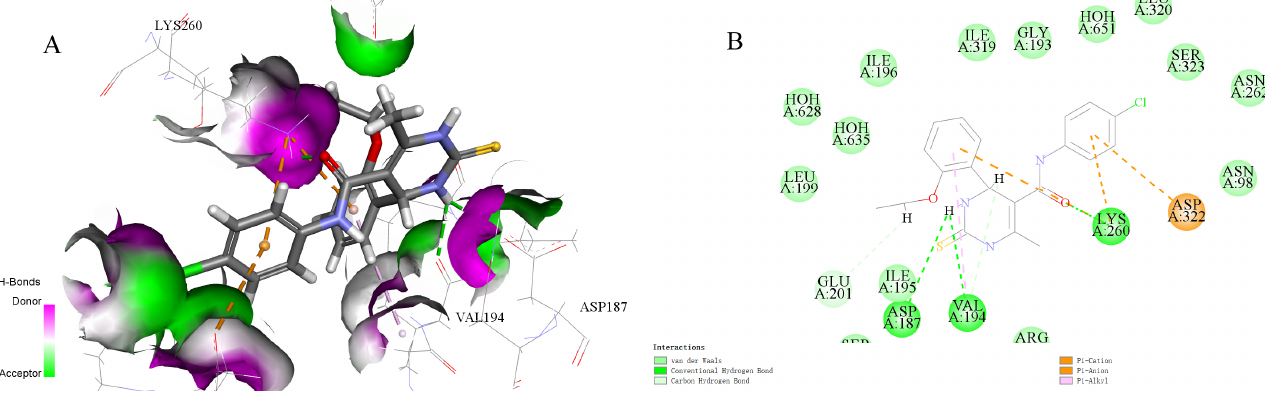
Figure 3. ( A ) The 3D view of the binding mode between the most potent compound C9 and kinesin Eg5; the pink and green zones represent the hydrogen bond interactions. ( B ) The schematic diagram generated using the 2D diagram of Discovery Studio 4.1 shows the interactions between the most potent compound C9 and the neighboring residues of kinesin